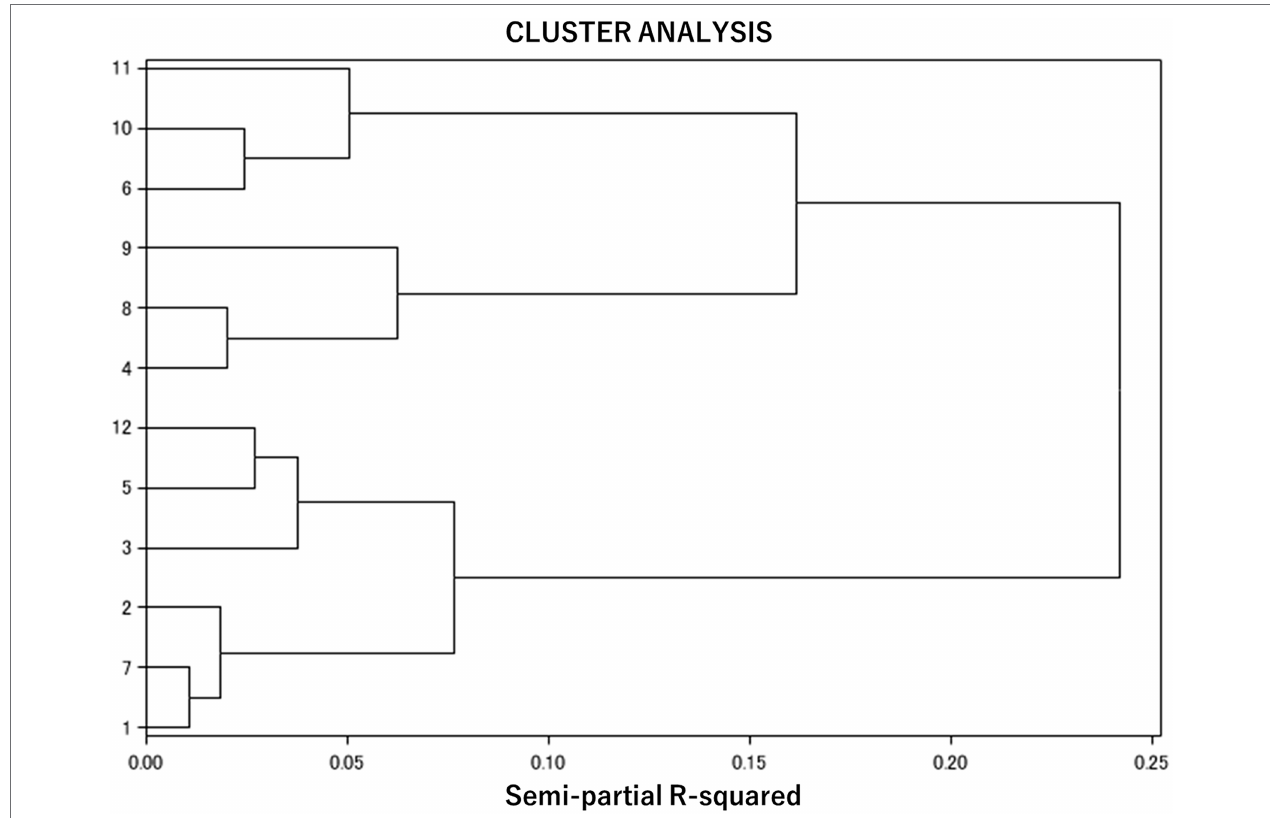
FIGURE 1 | Diagram of cluster